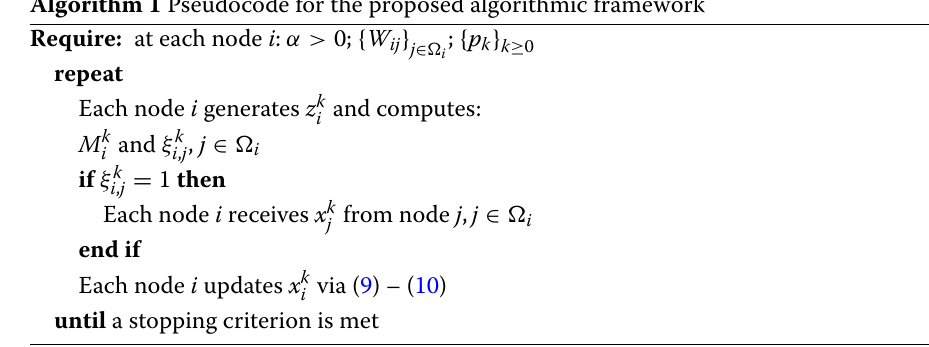
Algorithm 1 Pseudocode for the proposed algorithmic